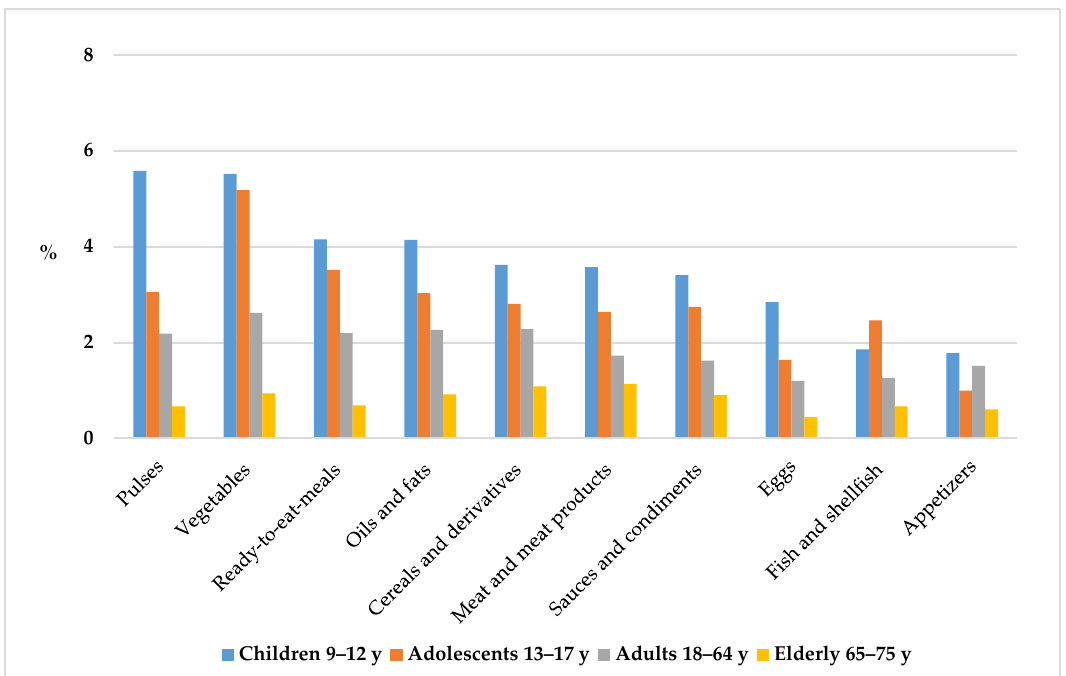
Figure 6. Food and beverage groups (%) contributing to plate waste across different age groups from the ANIBES study population.